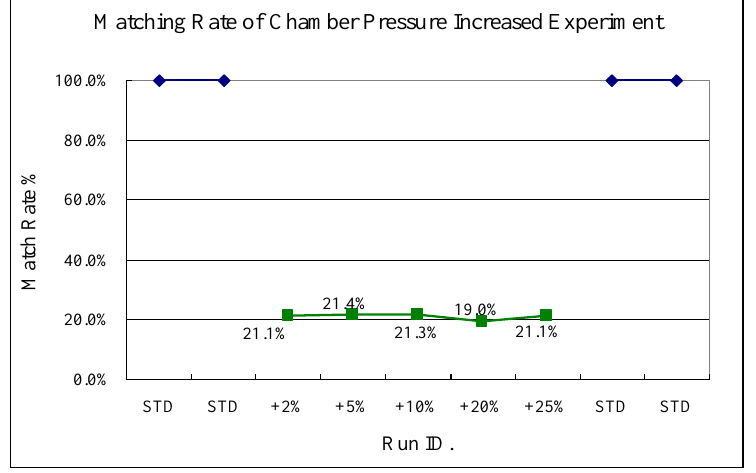
Figure 17. Experiment 8, chamber pressure servo variance tested from 7.14 to 8.75 mtorr. (STD = 7 mtorr).